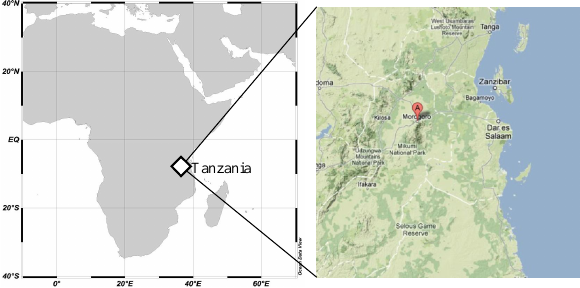
Fig. 1. Map showing the location of the sampling site of Morogoro,